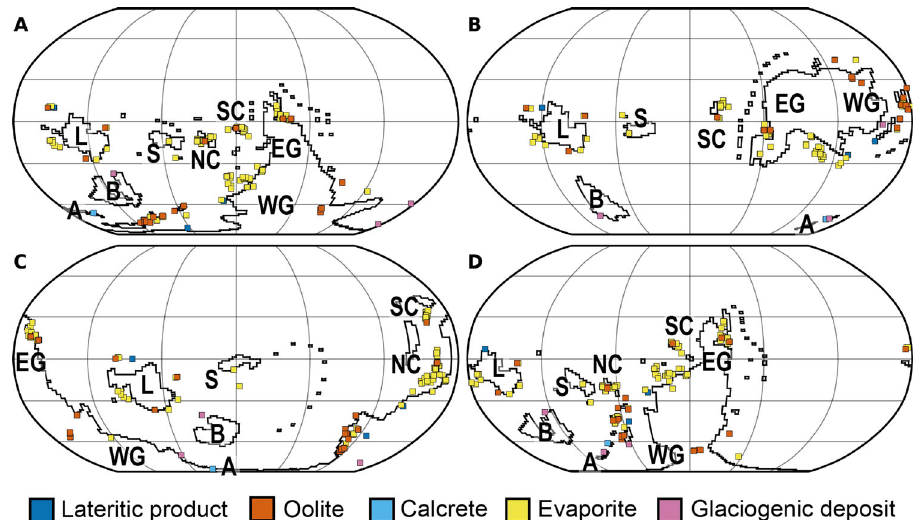
Fig. 2 Palaeo-positions of lower Cambrian climatically sensitive lithologies plotted on each of the continental con fi gurations (A – D) investigated here. See Fig. 1 for explanation of the con fi gurations and continent